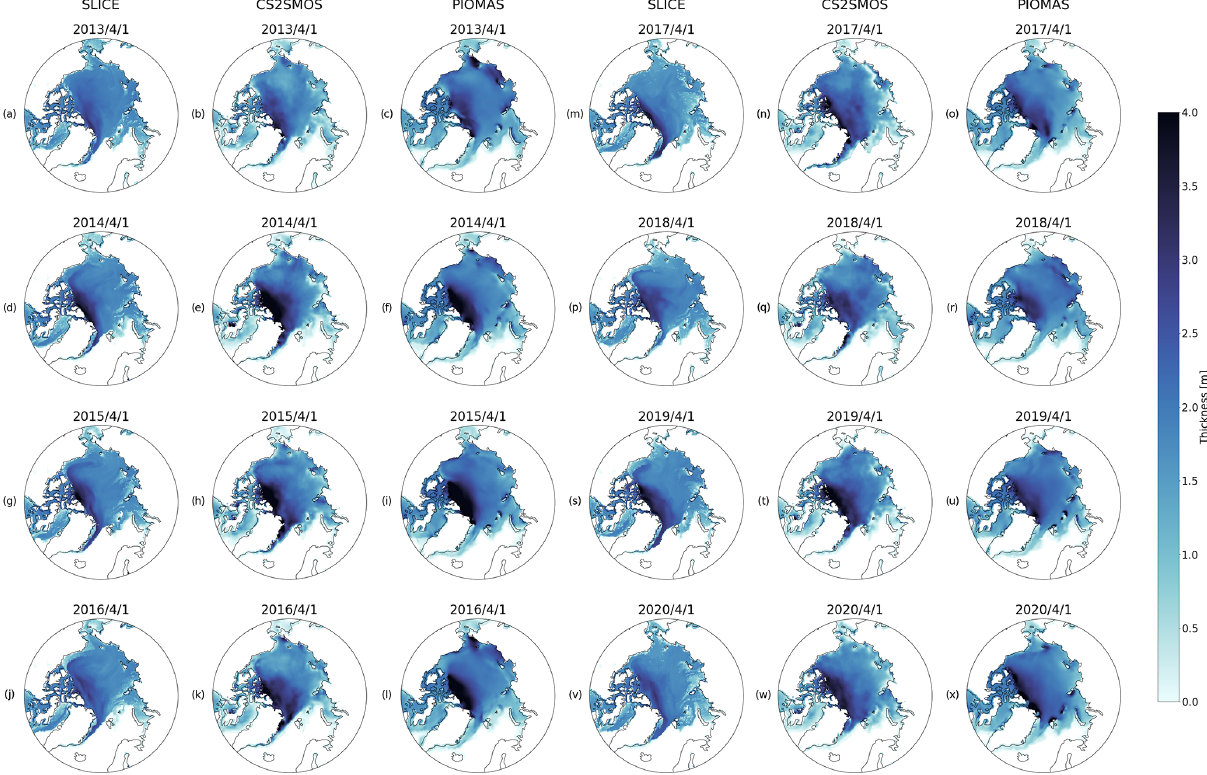
Figure A2. For the sea ice growth seasons ending in (a–c) 2013, (d–f) 2014, (g–i) 2015, (j–l) 2016, (m–o) 2017, (p–r) 2018, (s–u) 2019, and (v–x) 2020, (a, d, g, j, m, p, s, v) SLICE sea ice thickness for 1 April, (c, f, i, l, o, r, u, x) AWI CS2SMOS sea ice thickness from 1 April, and (b, e, h, k, n, q, t, w) PIOMAS sea ice thickness from 1 April.